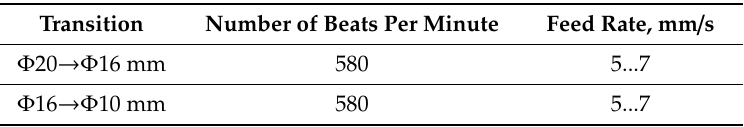
Table 2. Forging modes of Ti-Al-Mo-V alloy